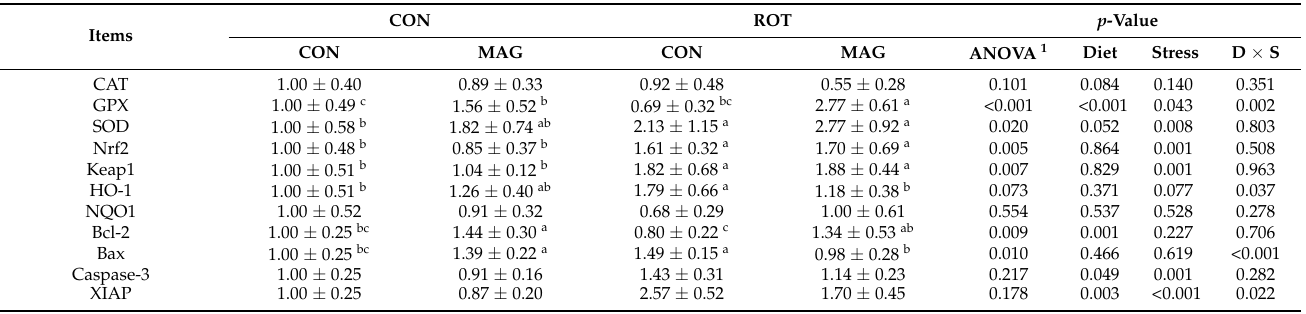
Figure 1. Effect of dietary magnolol supplementation on histopathological examination and apoptosis of liver in broilers challenged with rotenone. ( A ) Representative micrographs of H&E staining of the liver tissue. All images were viewed at the magnification of 400 × through a microscope. ( B ) Representative micrographs of TUNEL staining of the liver tissue. All images were viewed at the magnification of 630 × through a microscope. Abbreviations: CON—birds were injected sunflower oil with a basal diet; ROT—birds were injected rotenone with a basal diet; MAG—birds were injected rotenone with a 300 mg/kg magnolol diet. Table 5. Effect of dietary magnolol supplementation on liver gene expression levels in broilers challenged with